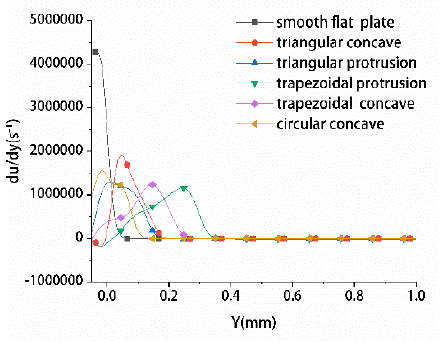
Figure 5. Velocity gradient at 2 mm of Mach number 0.5 Ma.